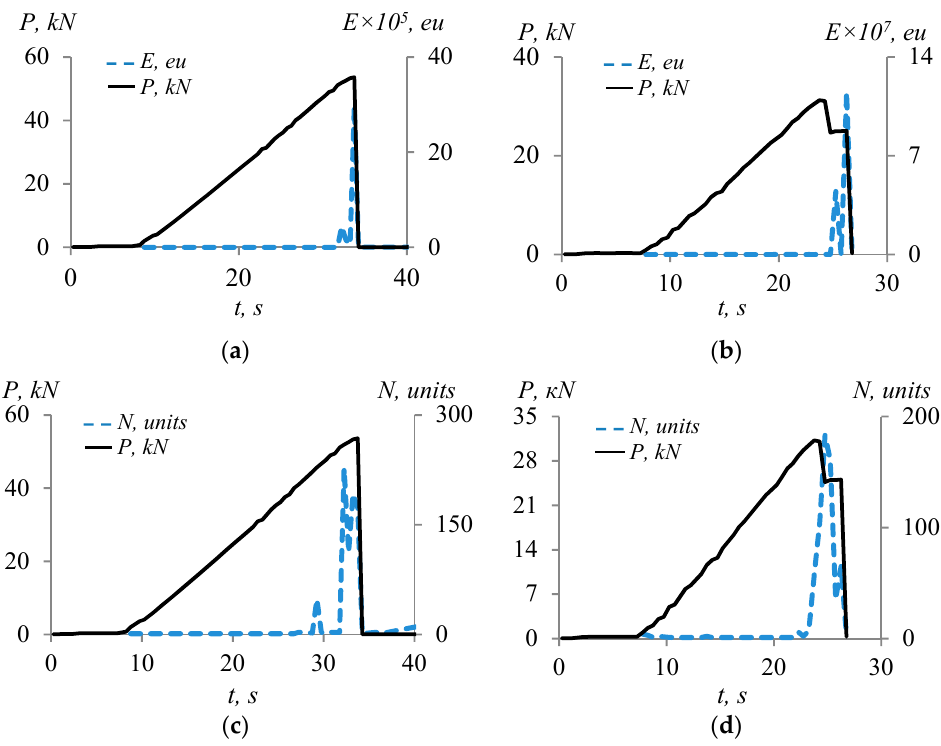
Figure 11. Diagrams of the dependence of the energy parameter of AE signals on time, combined with the loading curves: ( a ) dry sample 2/3; ( b ) saturated sample 2/18; and diagrams of the distribution of the number of registered AE signals versus time, combined with the loading diagram: ( c ) dry sample 2/3; ( d ) saturated sample